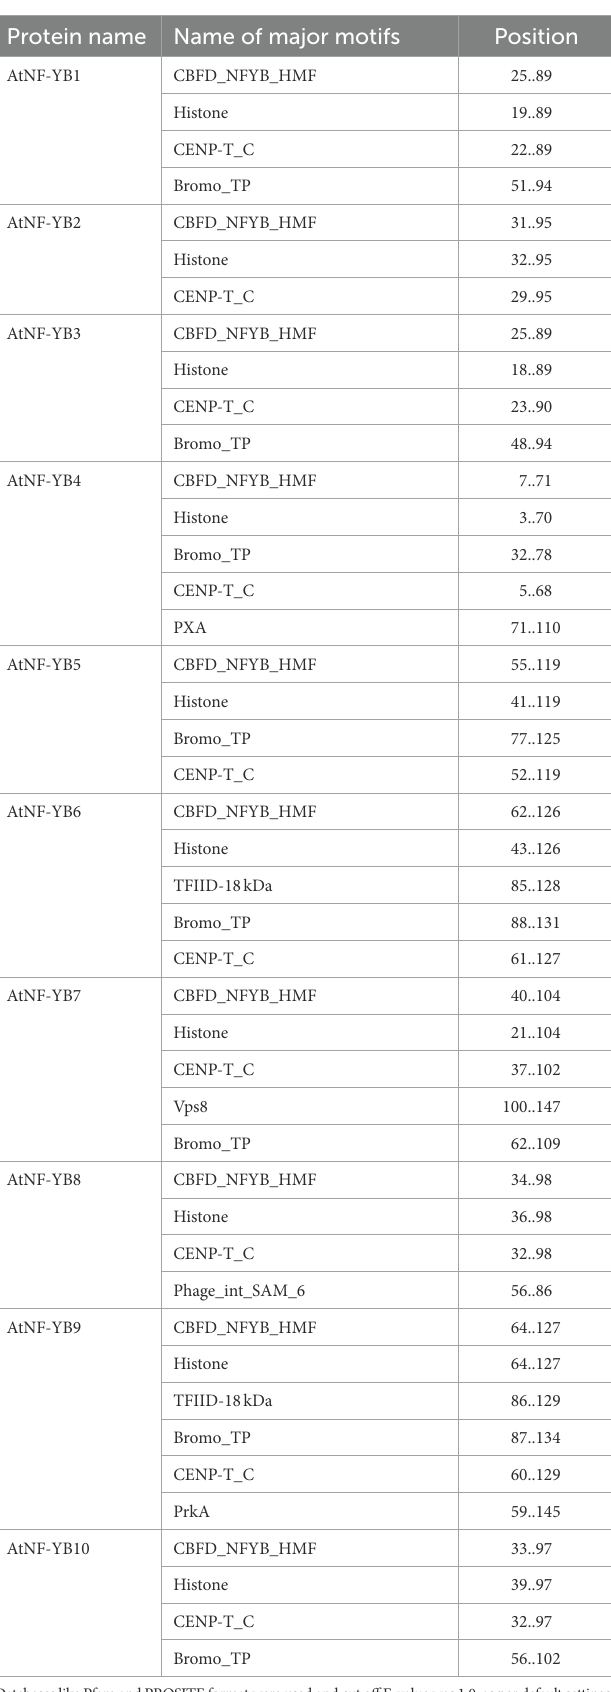
TABLE 3 Major motifs present in the 10 AtNF-YB proteins and their corresponding positions in the individual proteins, represented using the MOTIF Search